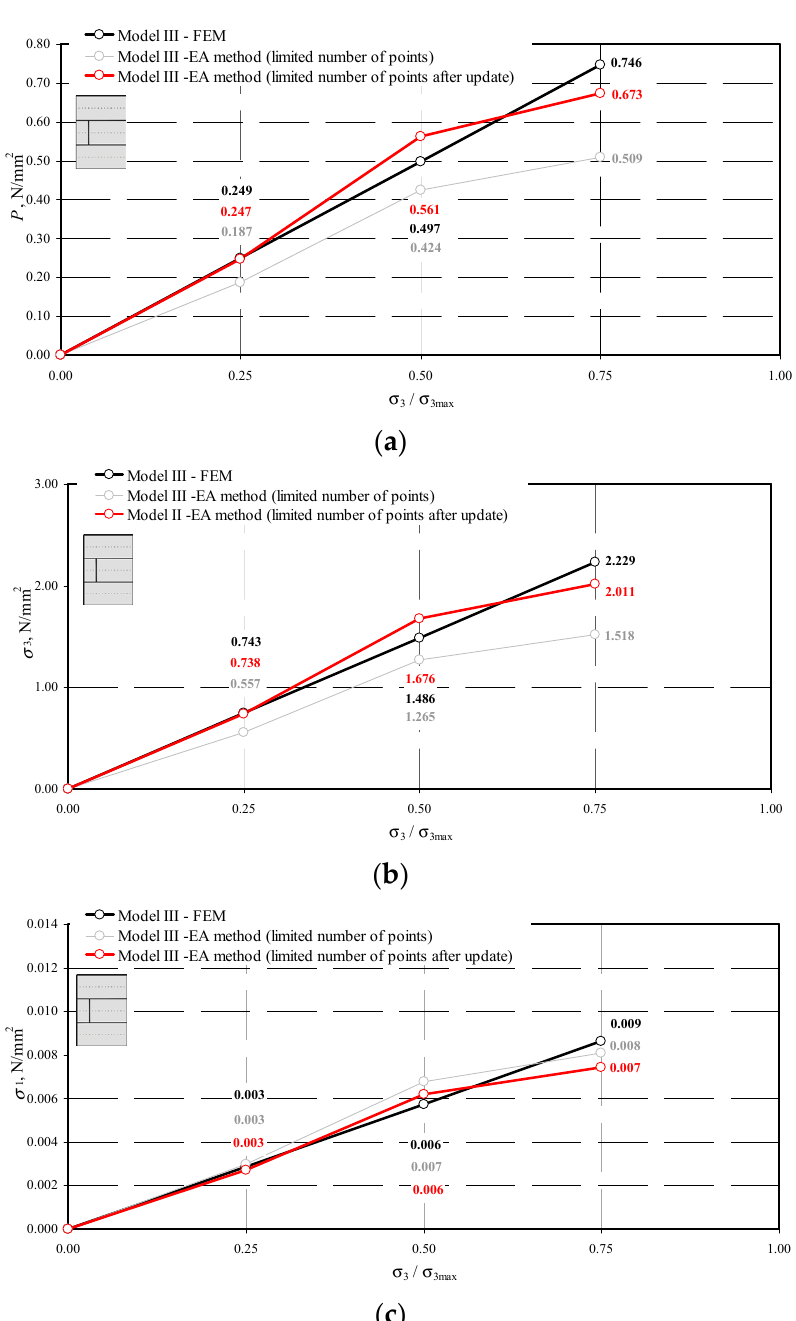
Figure 21. Comparison of stress values determined by the NDT and FEM methods for the model II-1: ( a ) mean hydrostatic stress; ( b ) normal stress perpendicular to the plane of bed joints; ( c ) normal stress parallel to the plane of bed joints.